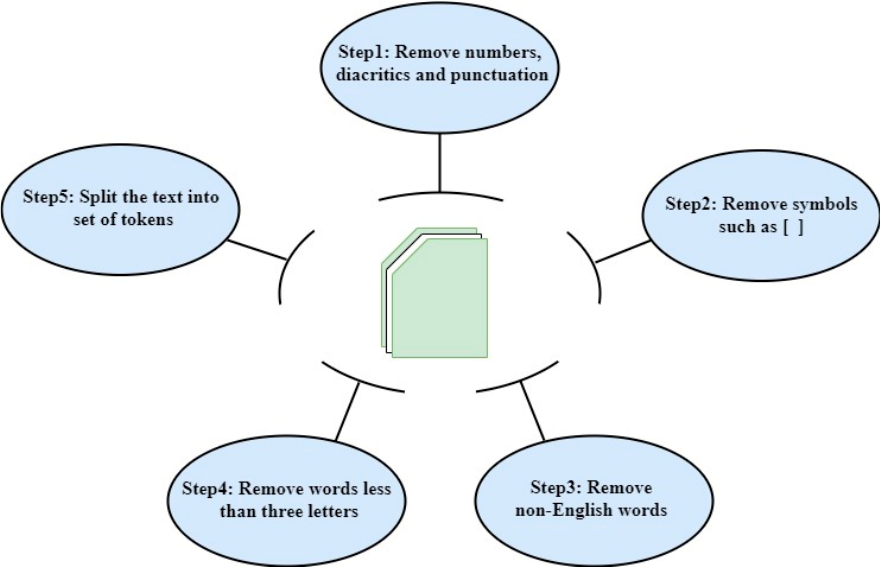
Figure 4. Tokenization and normalization steps.